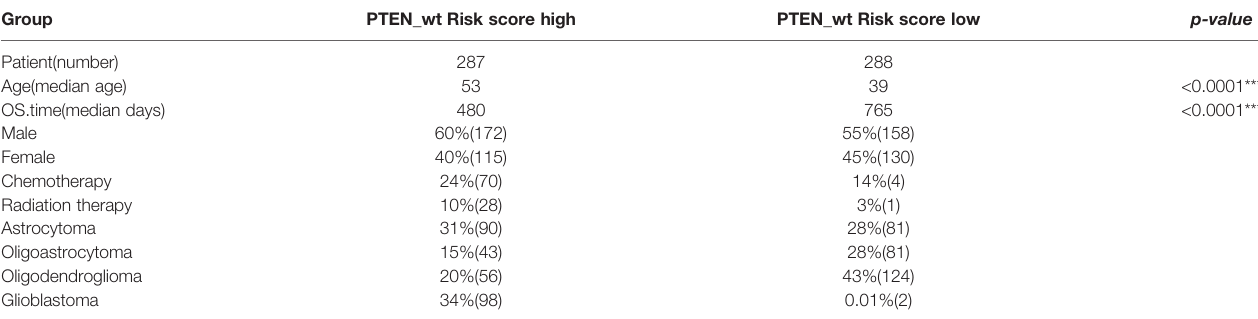
TABLE 2 | Clinical information about risk high and risk low patients in PTEN-wt subgroups (*** signi fi cant difference).